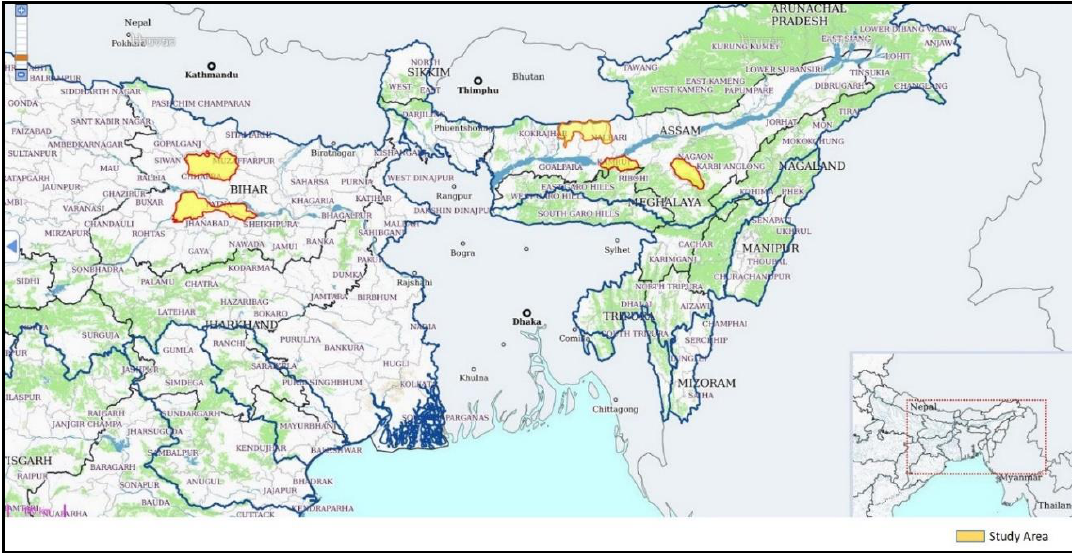
Figure 1. Location of study areas in Eastern India. Sources: Bhuvan: ISRO/NRSC, 2019 and Google Earth, 2019.